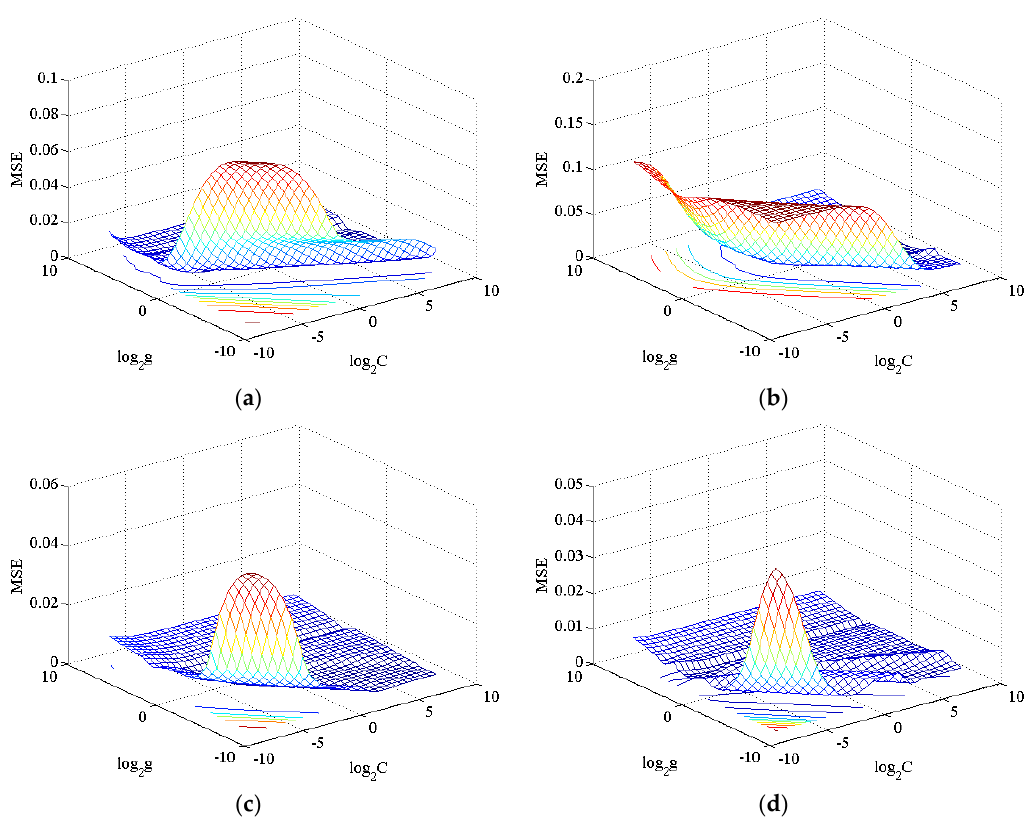
Figure 7. MSE surfaces of the cross ‐ validation process for the SVR PGA ( a ), SVR PGLA ( b ), SVR Mixed ( c ) and SVR CoPU ( d ), respectively.